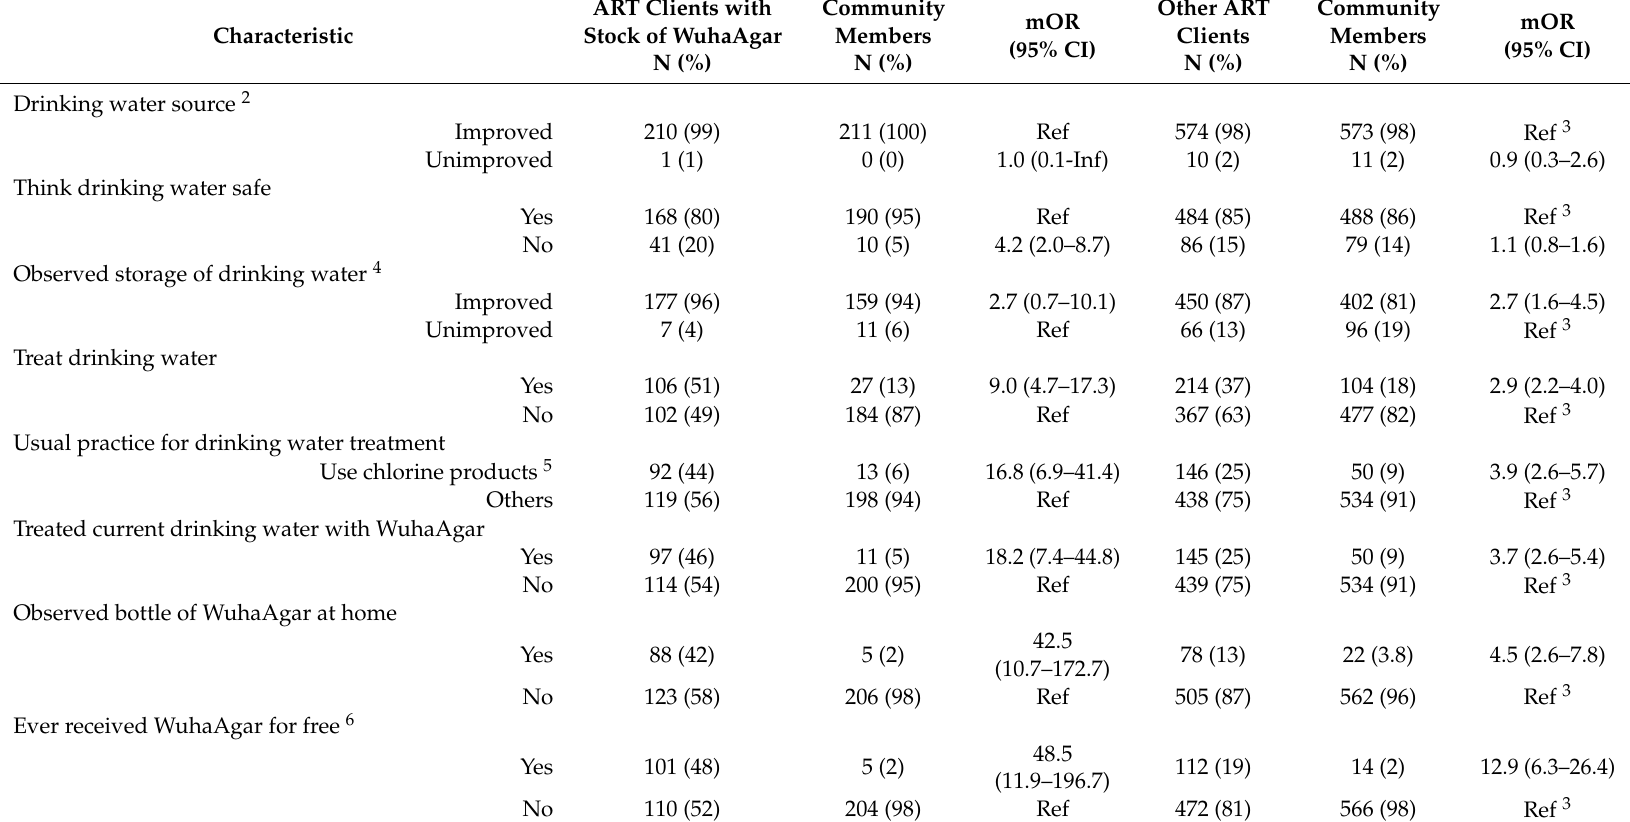
Table 4. Drinking water source, storage, treatment, and diarrhea incidence, N 1 (%), of ART clients attending clinics with stock of WuhaAgar ( n = 211) and their matched community members ( n = 211), other ART clients ( n = 584) and their matched community members ( n = 584), and matched odds ratio (mOR) of being the corresponding ART client, Ethiopia,